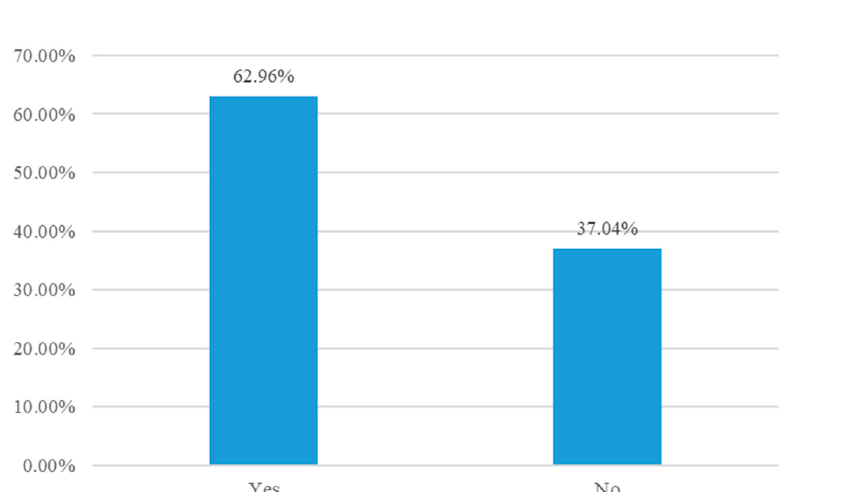
Figure 3. CICT who have specific training for the position. In addition, an interview was conducted with 3 CTIC volunteers who participated in the study. To identify their answers in the results section, the identification code “Tn” was used, where T refers to “teacher” and “n” to the identification